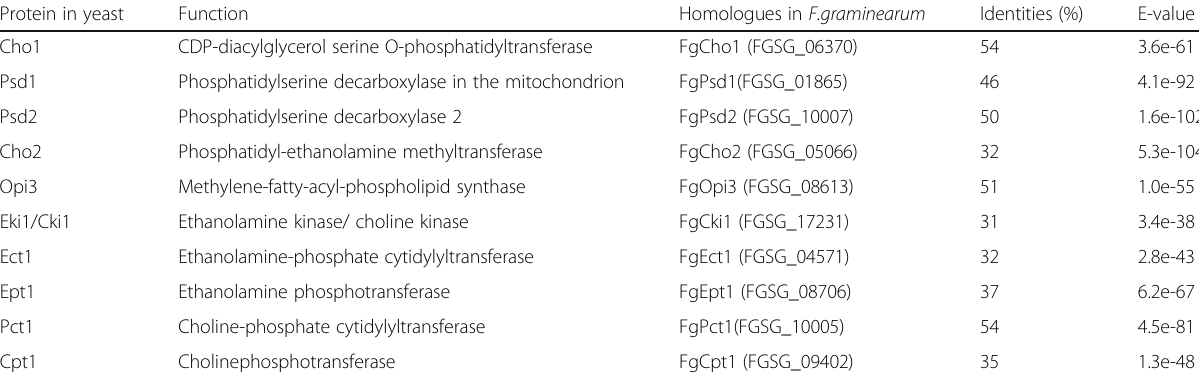
Table 1 Predicted proteins involved in the PE and PC biosynthesis pathway in F. graminearum Protein in yeast